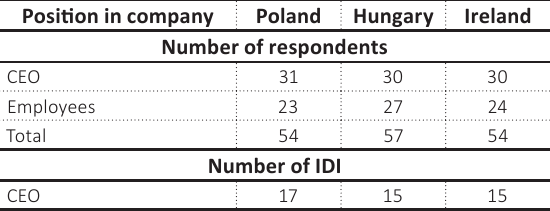
Table 1. Structure of the research sample